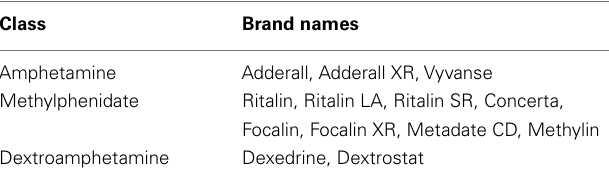
Table1 is a simplified list of the available stimulant medications and the groups to which they